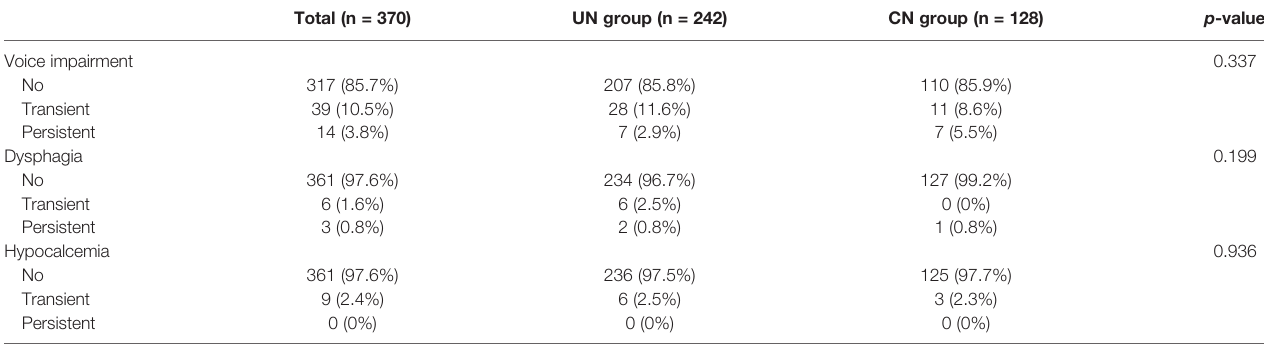
TABLE 3 | Postoperative complications of patients in the two groups.